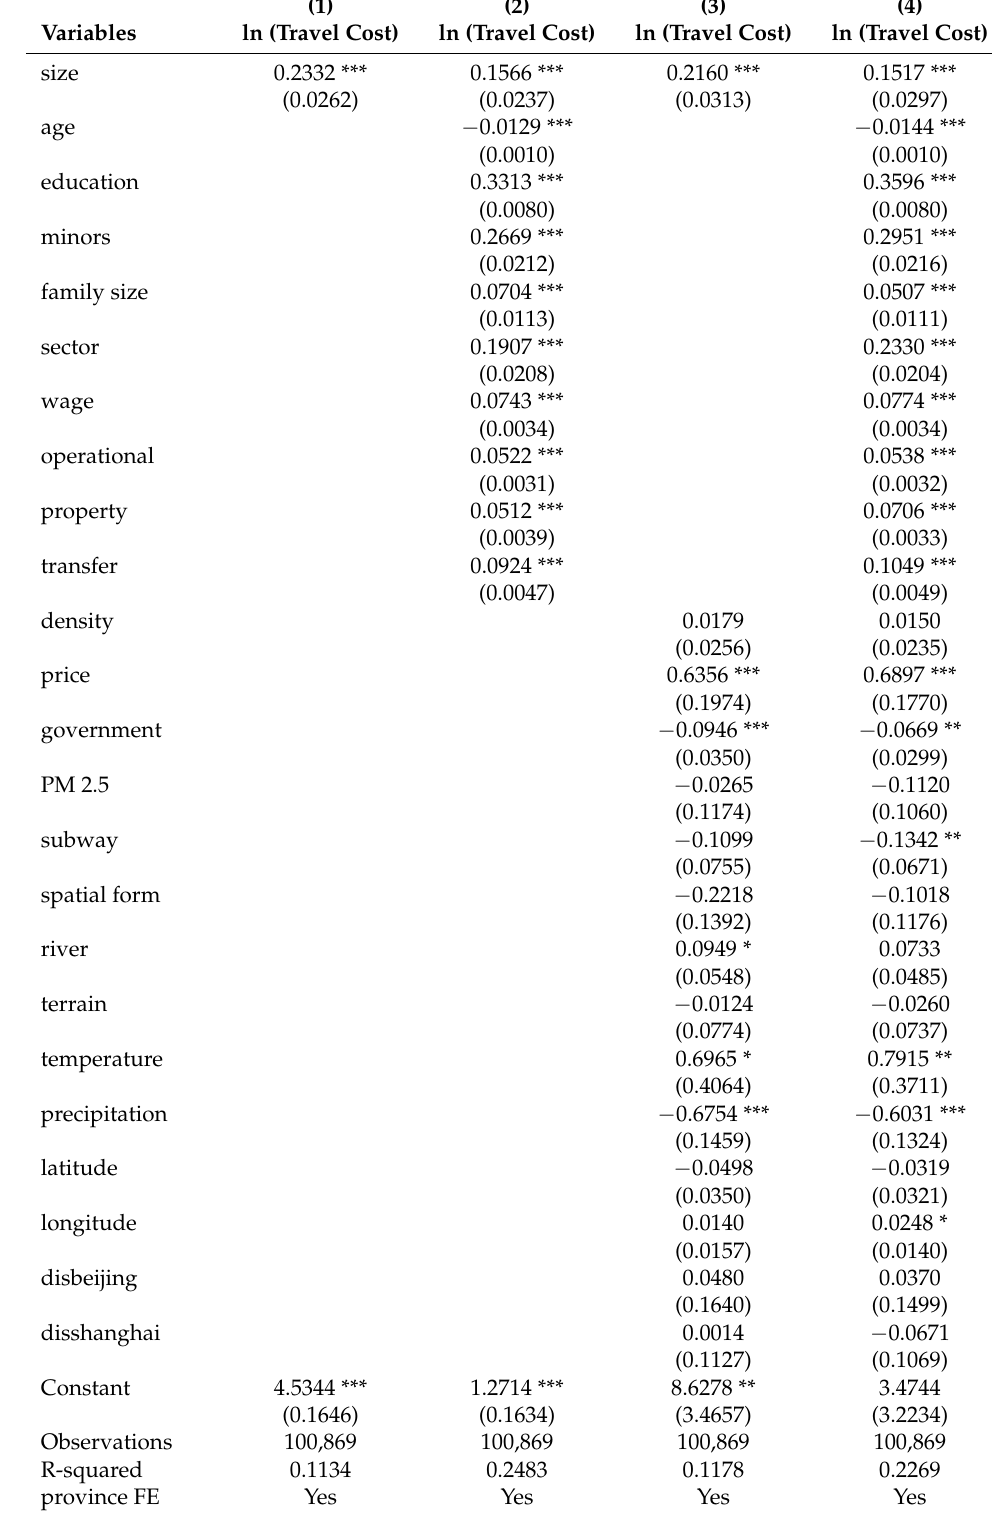
Table 2. The benchmark estimation